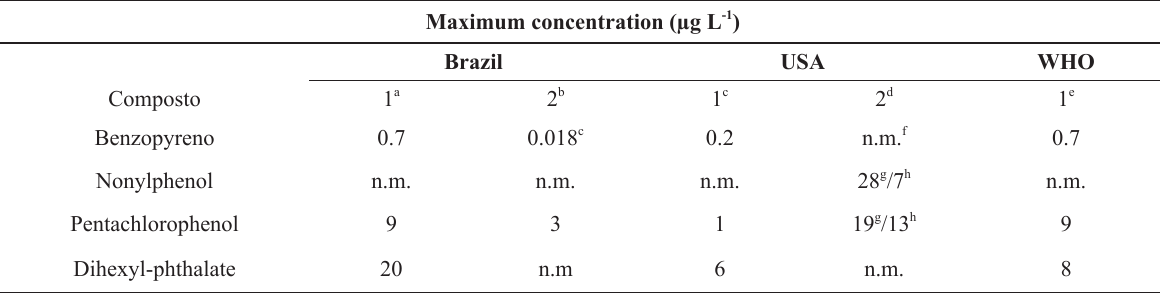
Maximum concentration (µg L -1 ) of endocrine disruptors in drinking water (1) and surface water (2) in accordance with national and international